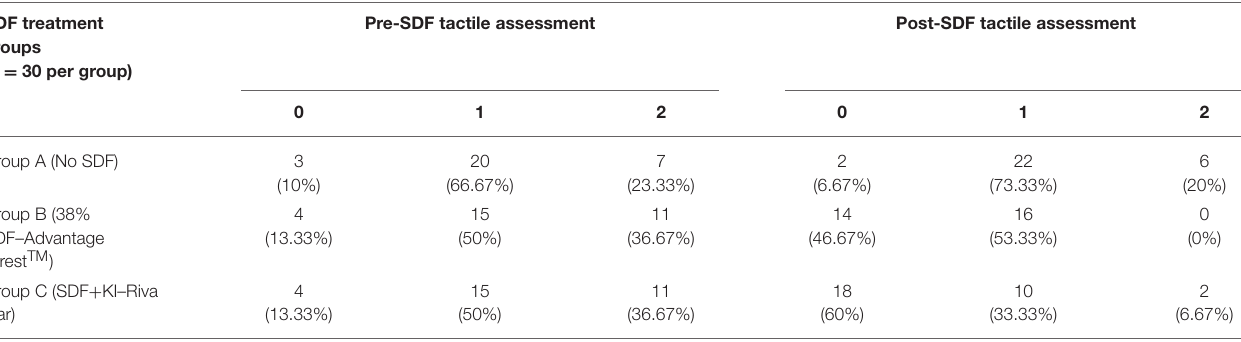
Pre-SDF tactile assessment